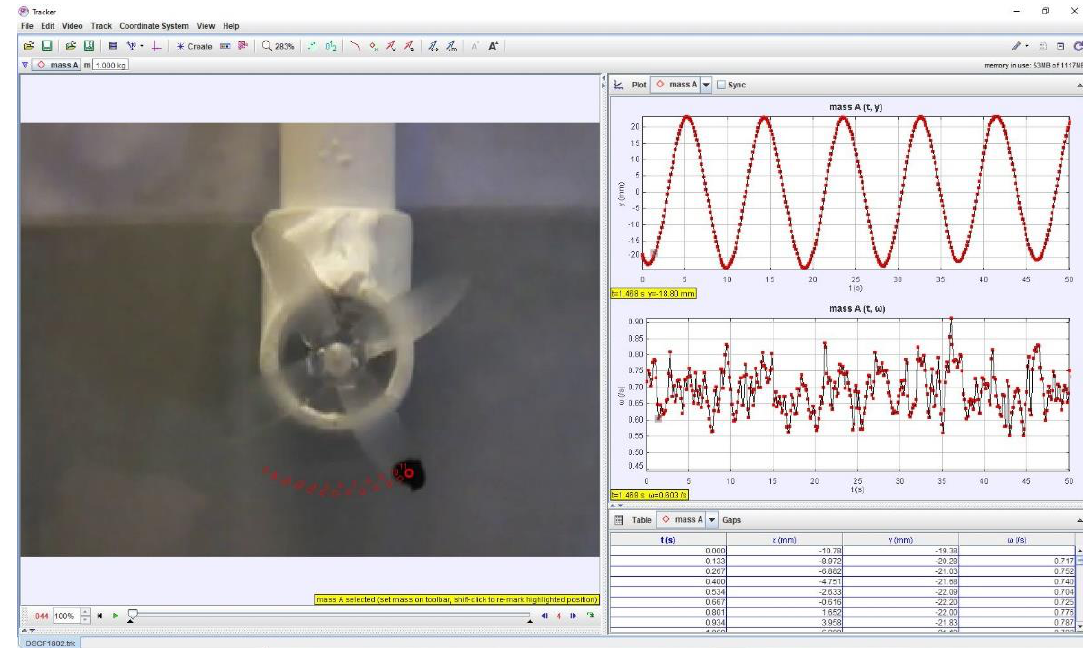
Figure 2. Auto-tracking the dot circle marker via Tracker for the experimental runs.